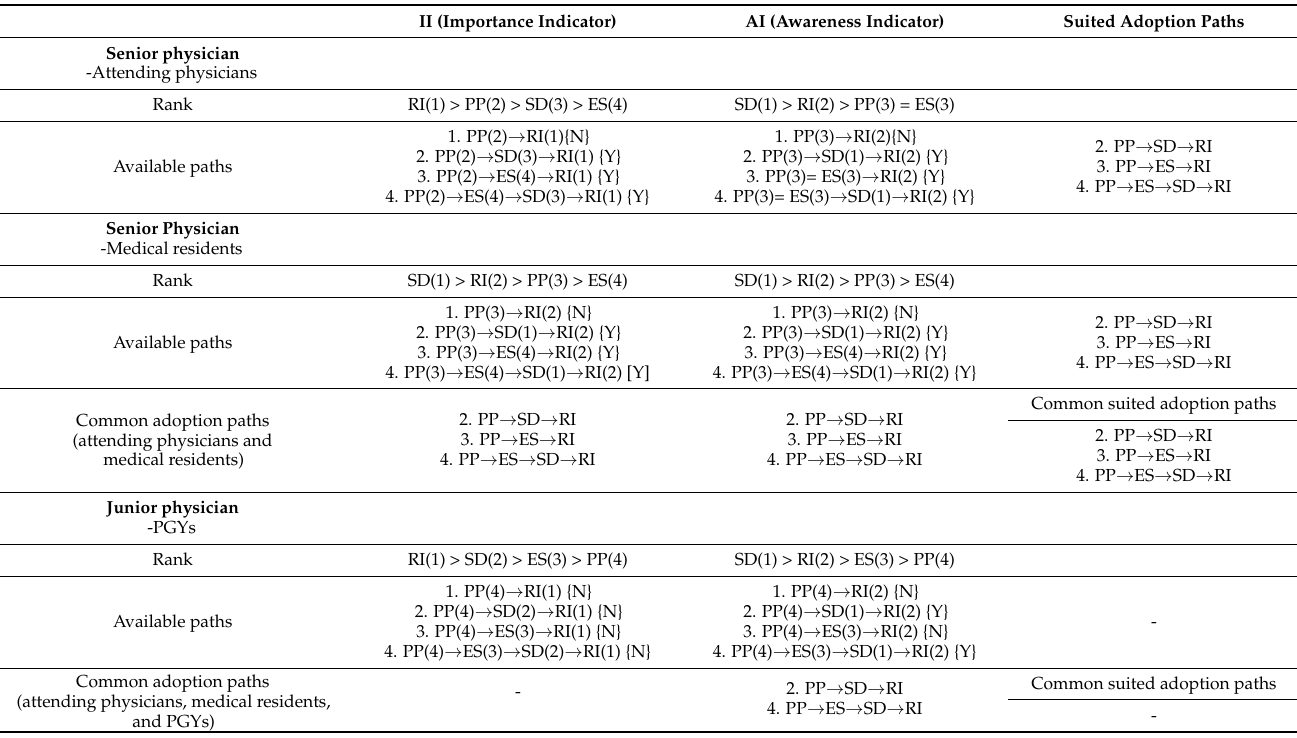
Table 14. The common suited adoption paths for SDM competency development of SDM tasks (attending physicians, medical residents, and